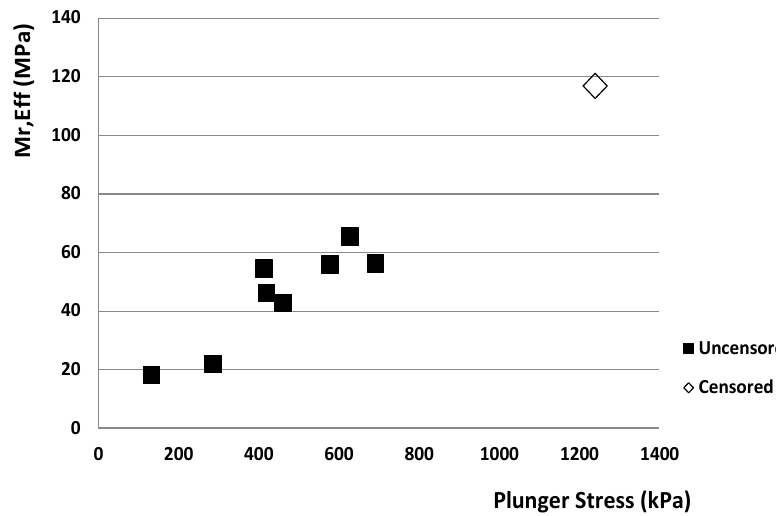
Figure 13. Dependence of resilient modulus M r,eff on plunger stress for uncensored data.